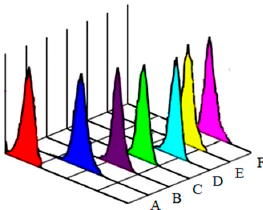
Figure 1. ROS levels of hepatocytes exposed to aniline. ROS levels gradually increased with concentration of aniline, in a dose-response relationship (A–D). A. 0 µ g/mL; B. 2.50 µ g/mL; C. 5.0 µ g/mL; D. 10.0 µ g/mL; E. 10.0 µ g/mL + 20 mmol/L NAC; F. Positive control (H 2 O 2